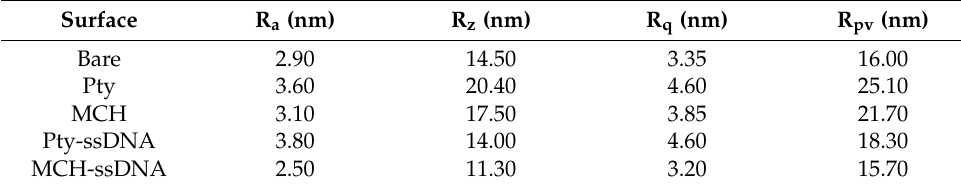
Figure 4. The 5 µ m × 5 µ m AFM images tapped in contact mode: ( a ) bare, ( b ) Pty-film-modified, and ( c ) MCH-SAM-modified gold sensor chips. The peak height profiles along the lines for ( a – c ) are shown in the figures marked ( d – f ), respectively. Table 2. Roughness parameters of the sensor chip